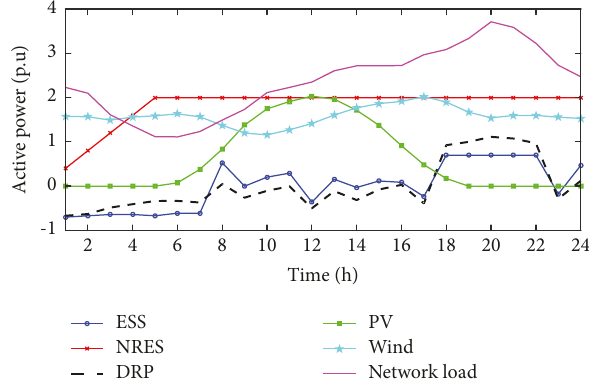
Figure 9: Daily expected active/reactive power curve of the SDN station.